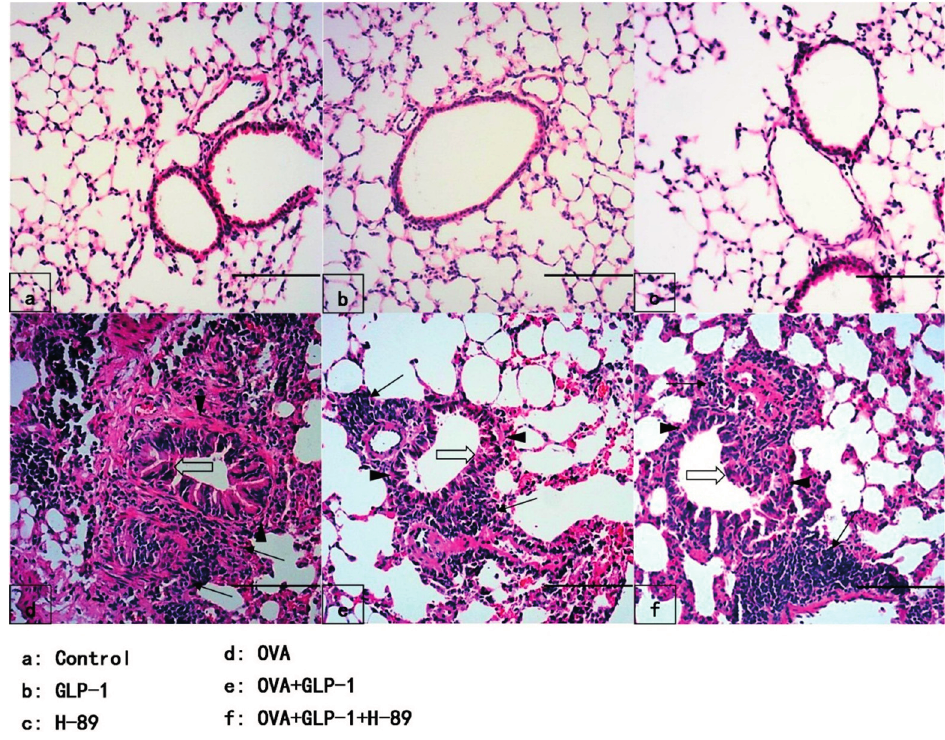
Figure 1. GLP-1 improves pulmonary pathological alterations in OVA-induced chronic asthma. After 81 days of OVA sensitization and challenge, mice were sacrificed and their right lower lungs were fixed. Then, tissue sections were stained with hematoxylin and eosin (H&E). The Figure demonstrates a representative view (×200) from each group. (Inflammatory cells (arrows); Goblet cells (open arrows); Airway basement membrane (triangles)) Scale bar = 100 μ